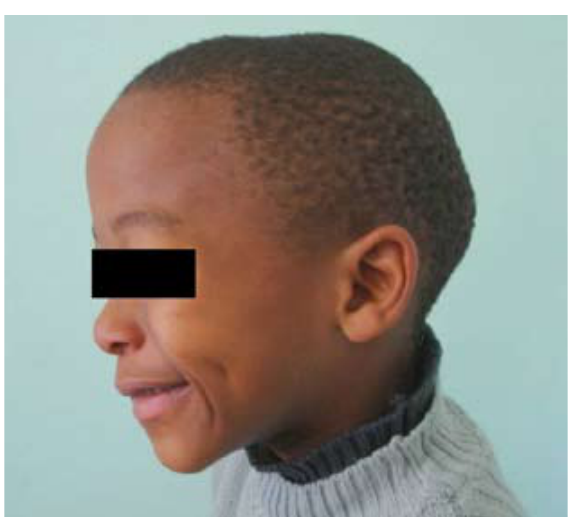
Fig. 2. Mild LA of the face, side